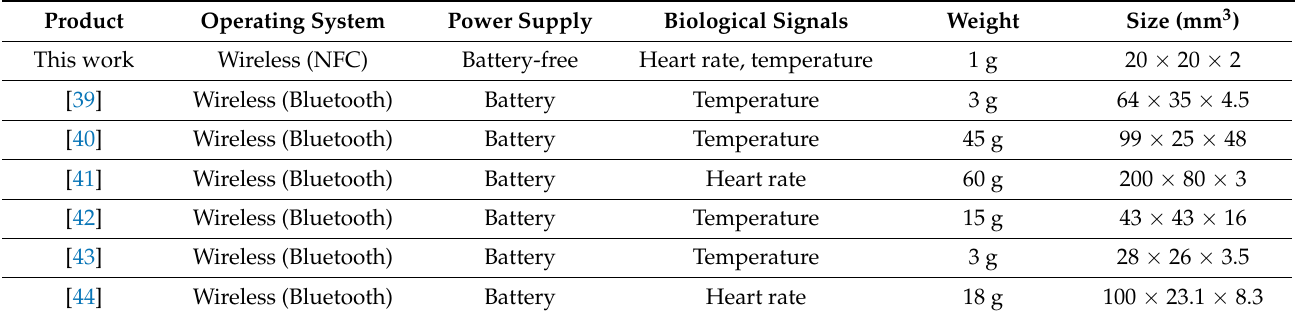
Table 1. Specifications of commercial wearable sensors in terms of operating system, power supply, biological signals, weight, and size.